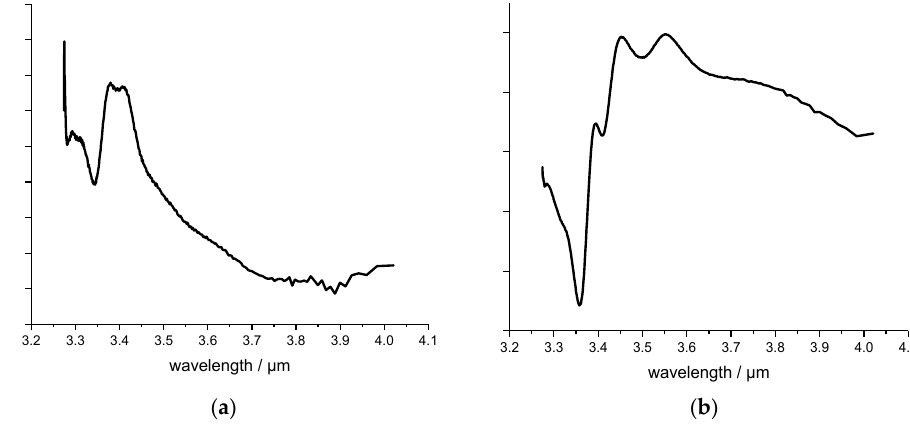
Figure 7. The PCA evaluation of black plastic samples ( a ) PC1; ( b ) PC2.